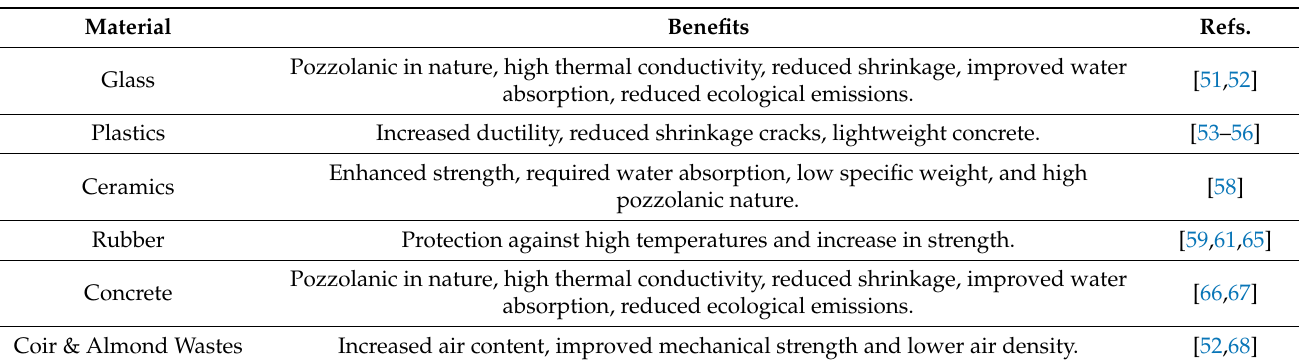
Table 1. Summary of various benefits of different wastes which can be incorporated as aggregates in